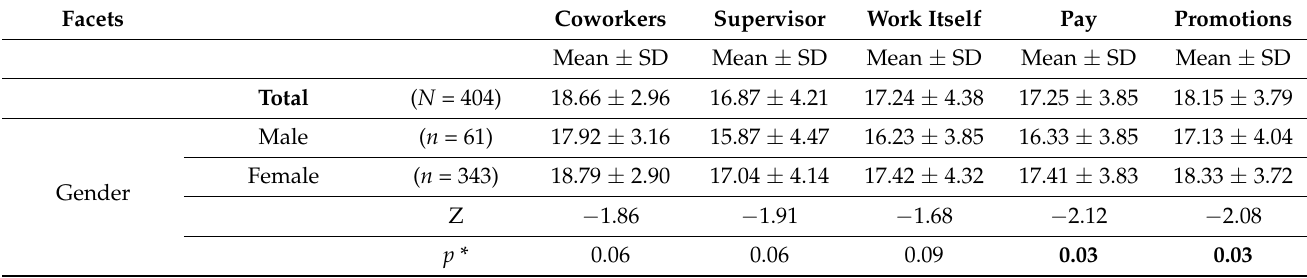
Table 2. The Job Descriptive Index facets results in the physiotherapists’ study group and selected subgroups (N =